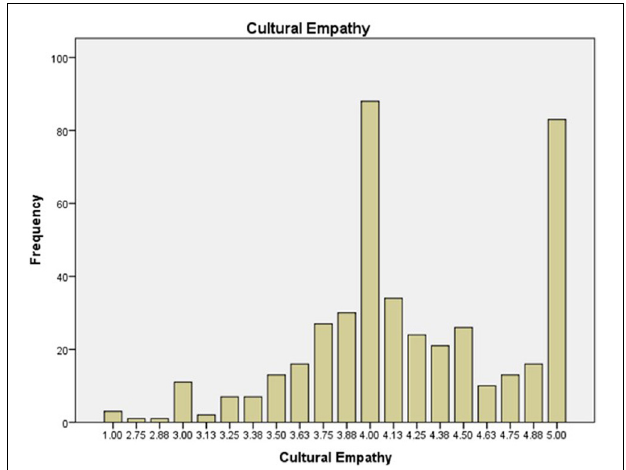
FIGURE 1 | Cultural Empathy mean scores.